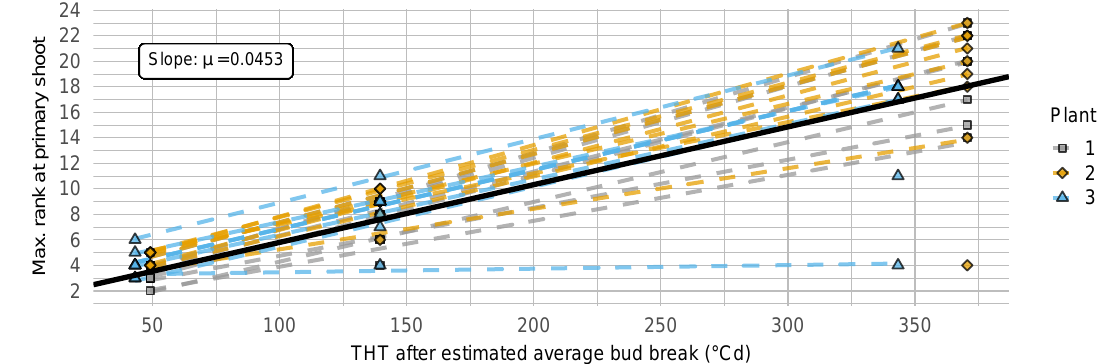
Figure 3. Estimation of phytomer appearance rate ( µ ) as the slope of linear mixed model fit.